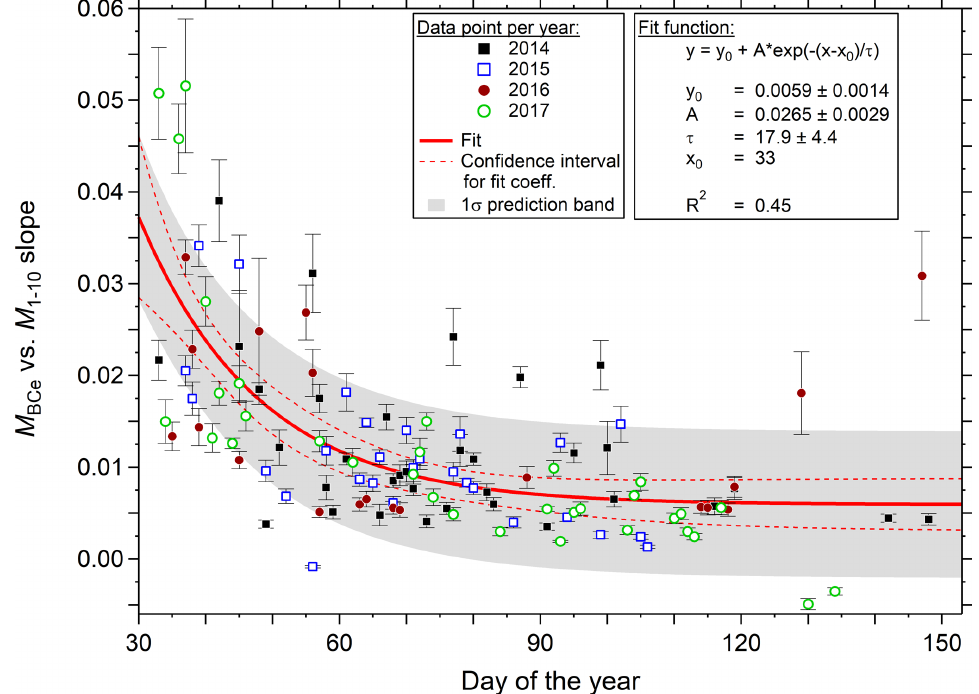
Figure 8. Temporal trend of the slopes from correlations between M BCe and M 1–10 from systematic bivariate regression fit analysis during the wet season period. Bivariate regression fits (with offset) have been performed every day during the wet season months of February to May for the years 2014 to 2017. The results have been filtered and only those slope data points from regression fits with a clear correlation (i.e., with a correlation factor R 2 > 0.5) are shown here. The error bars represent the standard error of the slope. To emphasize the overall trend, an exponential fit has been added with its 1 σ prediction